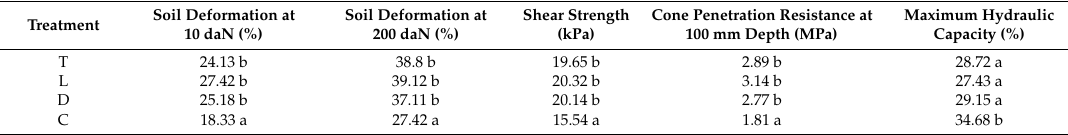
Table 2. Soil physical and mechanical parameters after eight years of sludge administration Treatment Soil Deformation at 10 daN